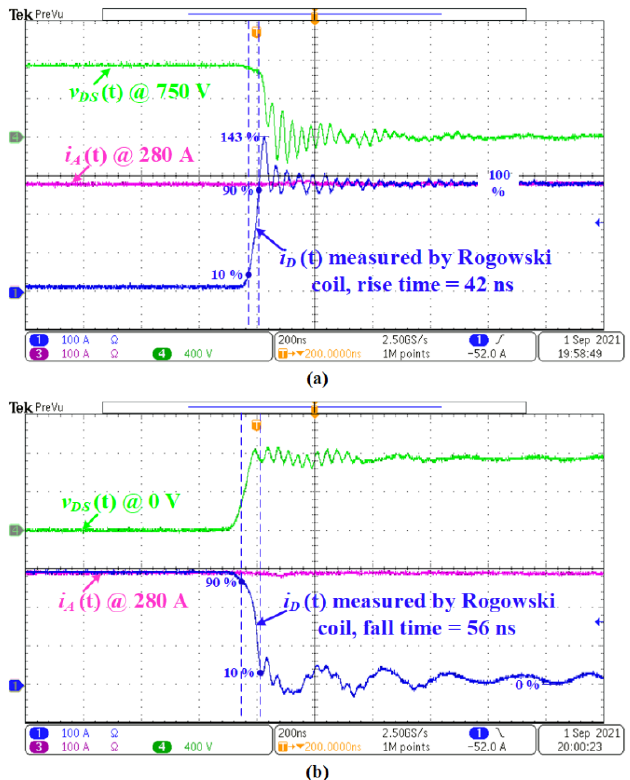
Figure 20. Switching waveforms of 1700 V, 325 A high-side SiC Power MOSFET in phase A of the traction converter. ( a ) Turn-on, ( b ) turn-off.